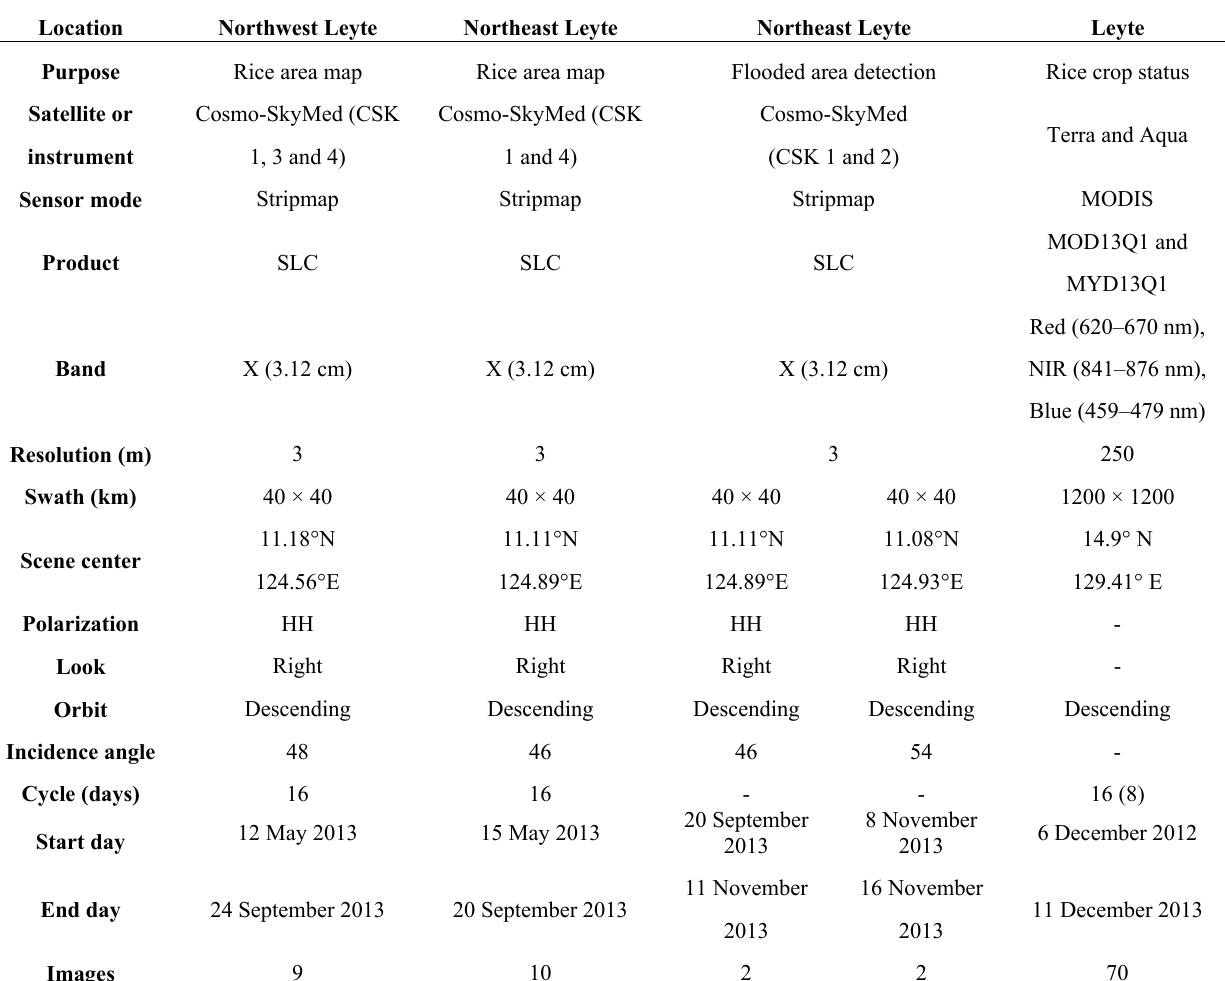
Table 1. EO data exploited in the